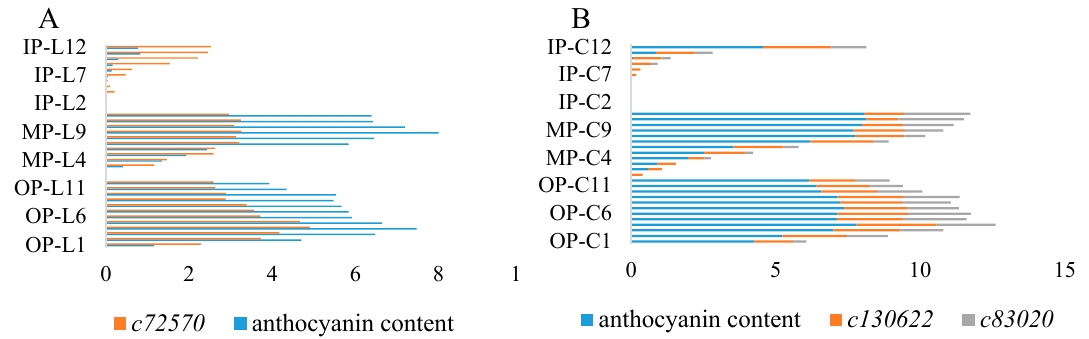
Figure 7. Correlation between anthocyanin contents and gene expression levels. A: measurements of ‘Jiaoyan zhuanhong’; B: measurements of ‘Jiaoyan yanghong’; IP: inner petals; MP: middle petals; OP: outer petals; L1–L12: stage 1–12 of ‘Jiaoyan zhuanhong’; C1–C12: stage 1–12 of ‘Jiaoyan yanghong’; c72570, c130622, and c83020 were genes annotated as encoding 3GT, 3GT, and 3MAT.